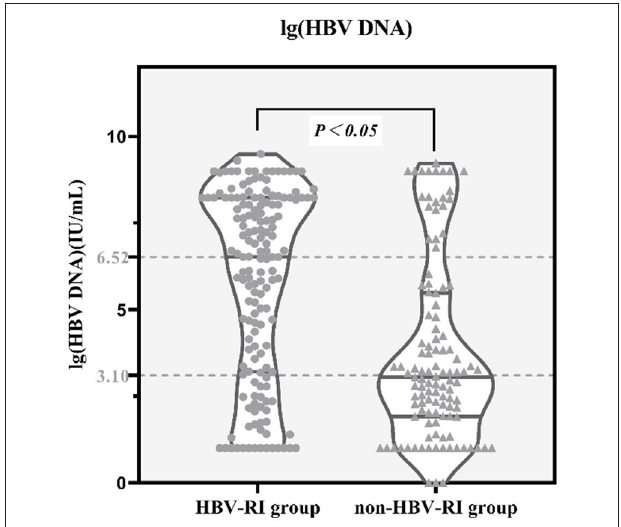
FIGURE 4 | lg(HBV DNA) between the HBV-RI group and the non-HBV-RI group. HBV-RI group, HBV-related inflammation group; non-HBV-RI group, Non-HBV-related inflammation group; the median value of lg (HBV DNA) (HBV DNA was calculated by denary logarithm) in the HBV-related inflammation group was 6.52 IU/L, whereas in the non-HBV-related inflammation group was 3.10 IU/L, and the difference had statistically significant ( P < 0.05).